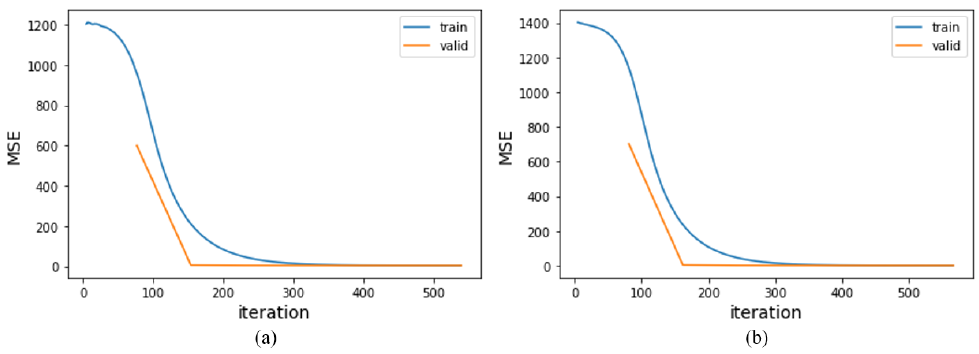
Figure 4. Training and validation MSE versus the number of iterations. ( a ) ideal case; ( b ) non- ideal